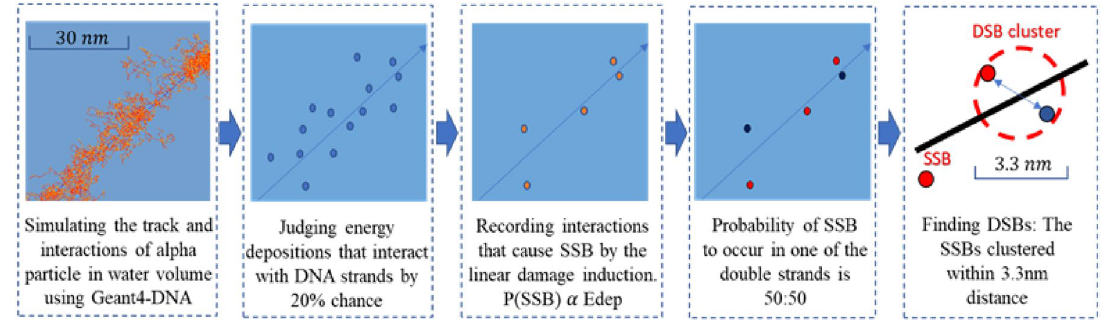
Figure 2. A computational scheme from alpha particle track simulation using GEAN4-DNA to DSB cluster registration using DBSCAN